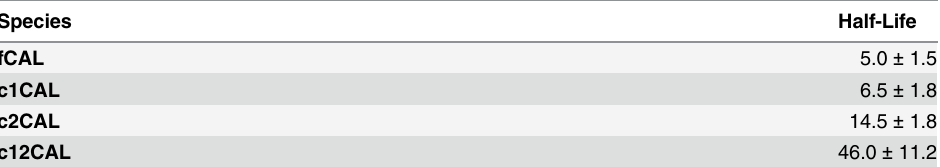
Table 1. Half-life of the different calnexin species. The standard deviation is estimated from the 382 mod- els (see Supplementary